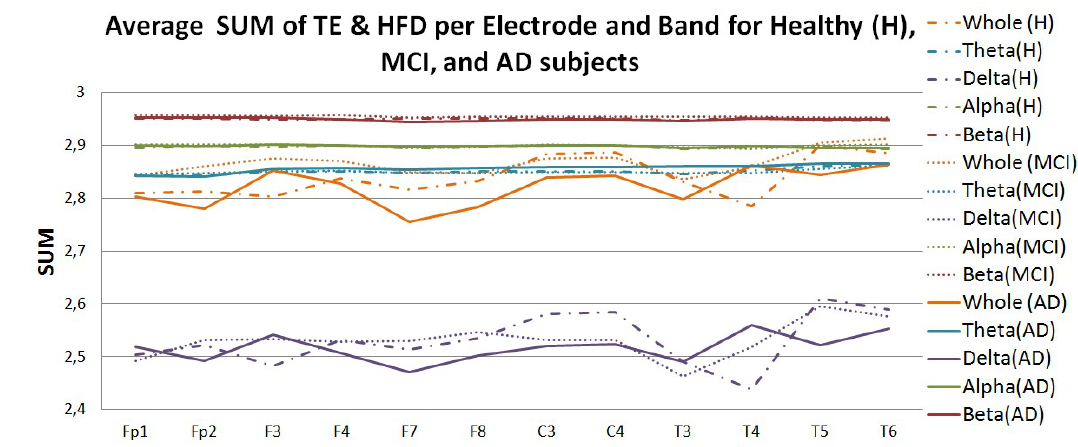
Figure A4: Addition of TE and HFD per electrode and band for the three sample groups (1’ examined interval – closed